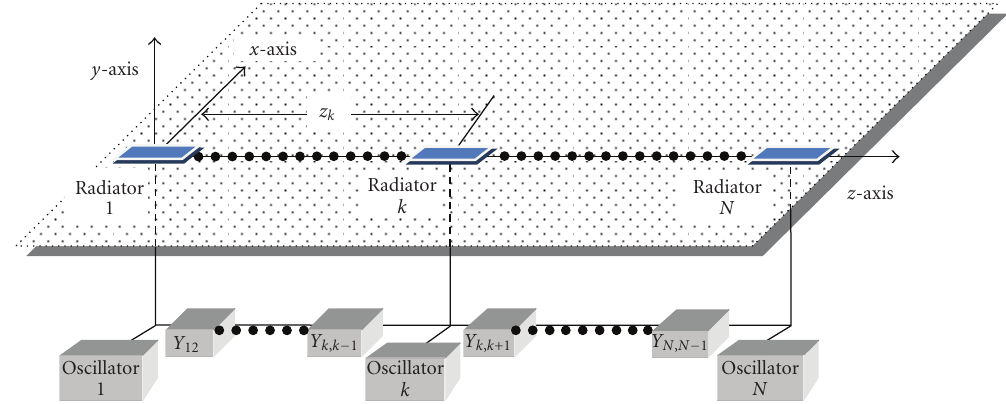
Figure 3: Bilateral injection-locking or mutual synchronization coupled oscillator’s